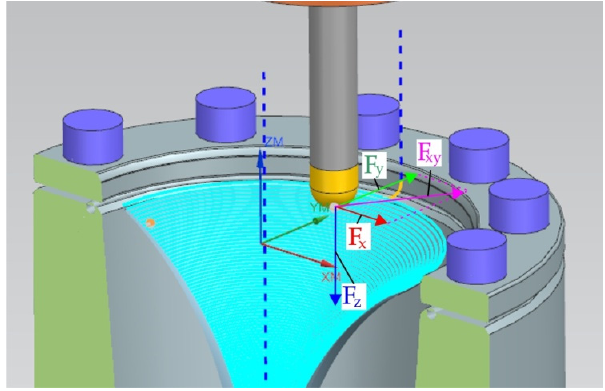
Figure 6. Force components in SPIF. Table 4. Results of the SPIF forming.